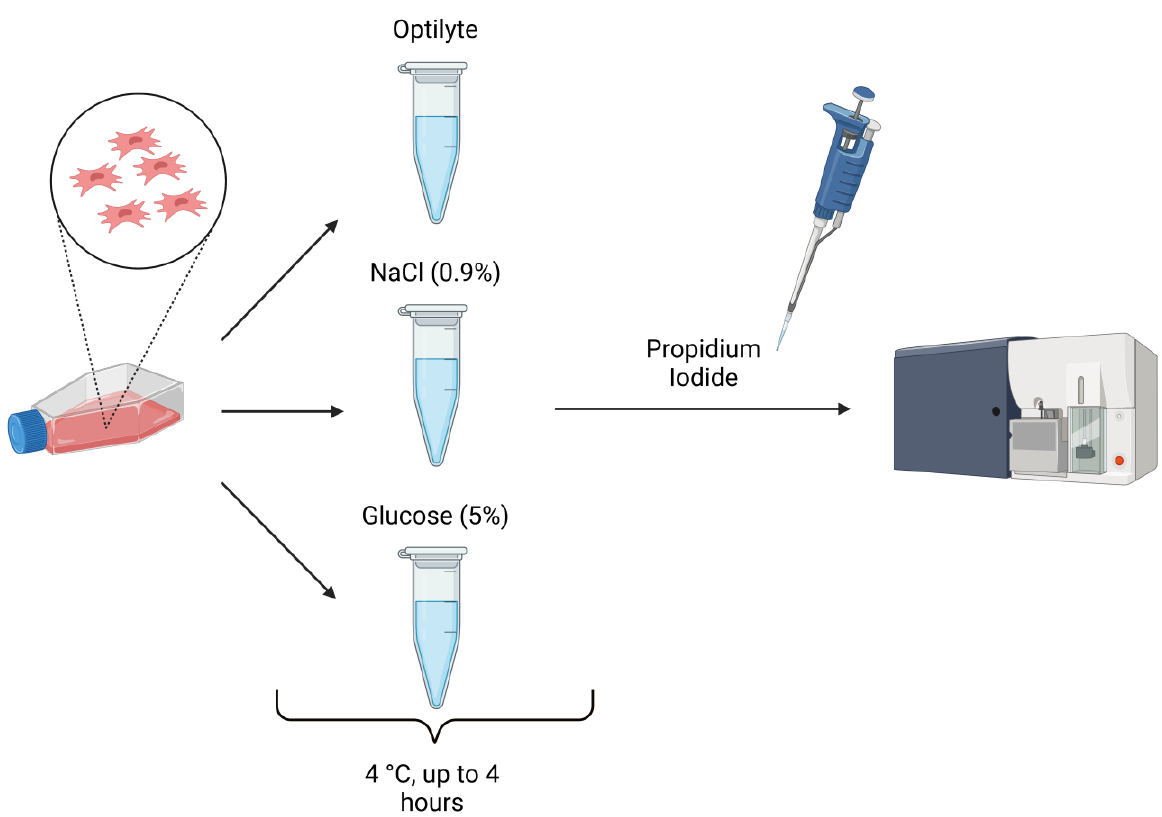
Figure 9. Experimental design.